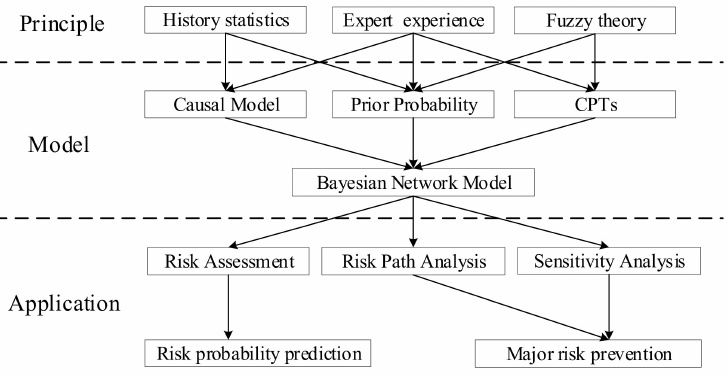
Figure 1. BN application framework for the risk